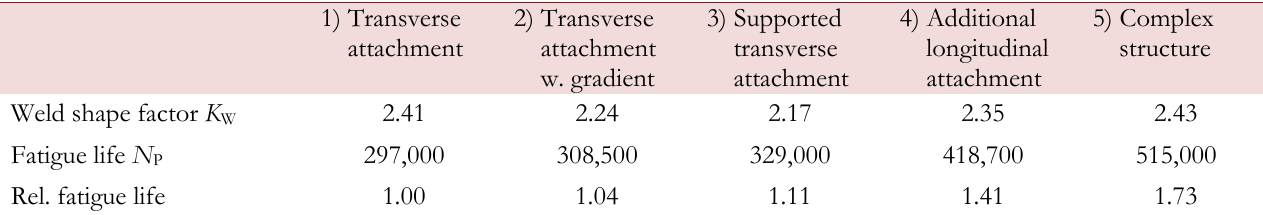
Table 2: Computed fatigue life N p for the same effective notch stress  eff = 425